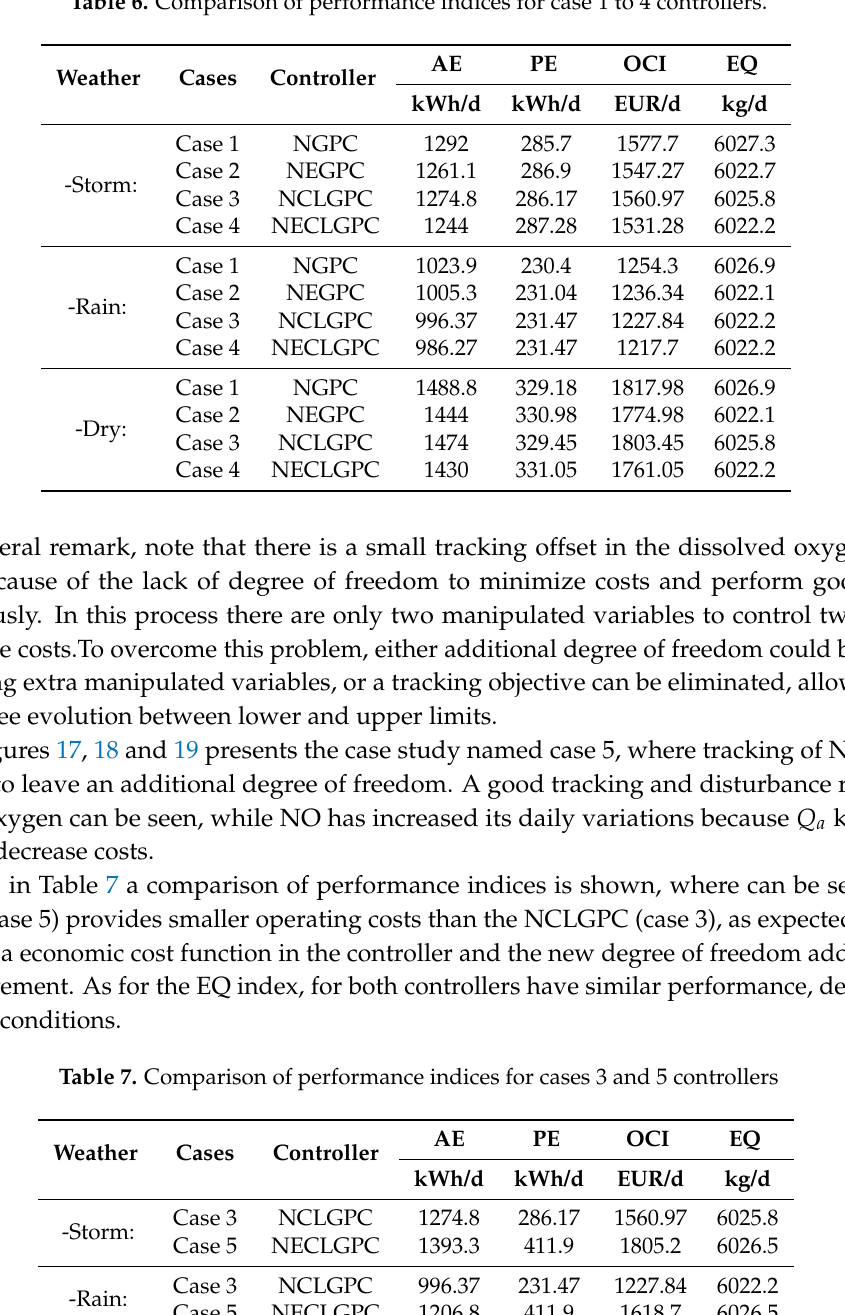
Table 6. Comparison of performance indices for case 1 to 4 controllers.